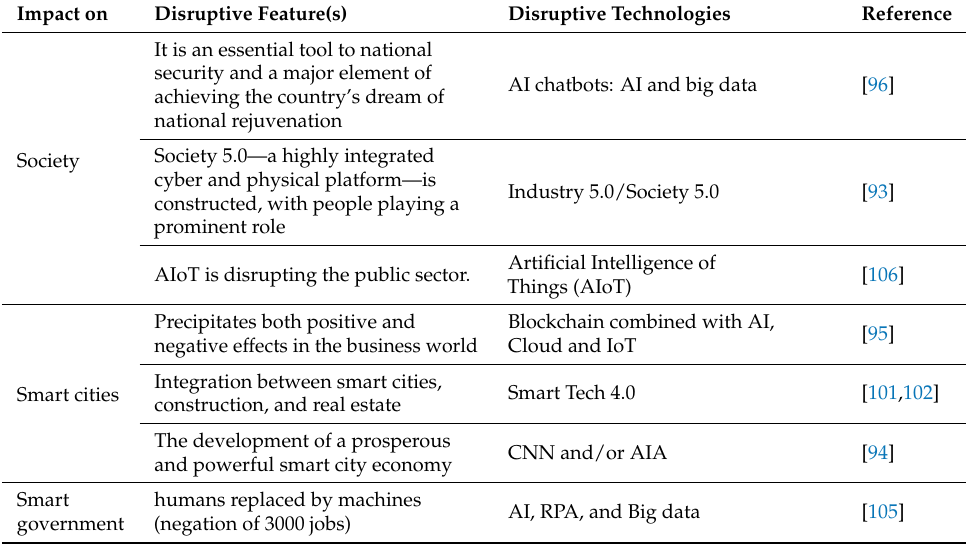
Table 16. Disruptive use of AI in urban